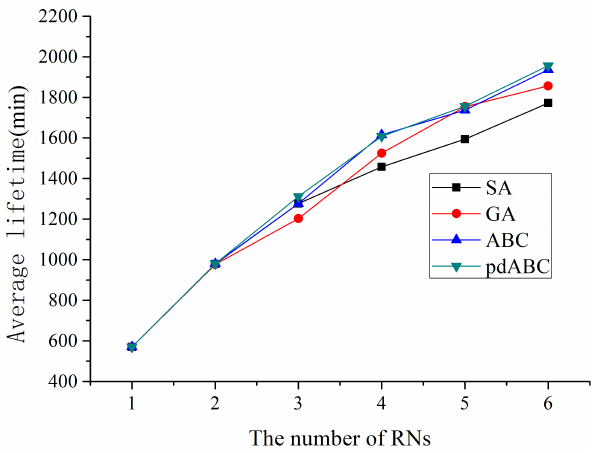
Figure 7. WSN lifetime optimization with different number of RNs in 100 × 100